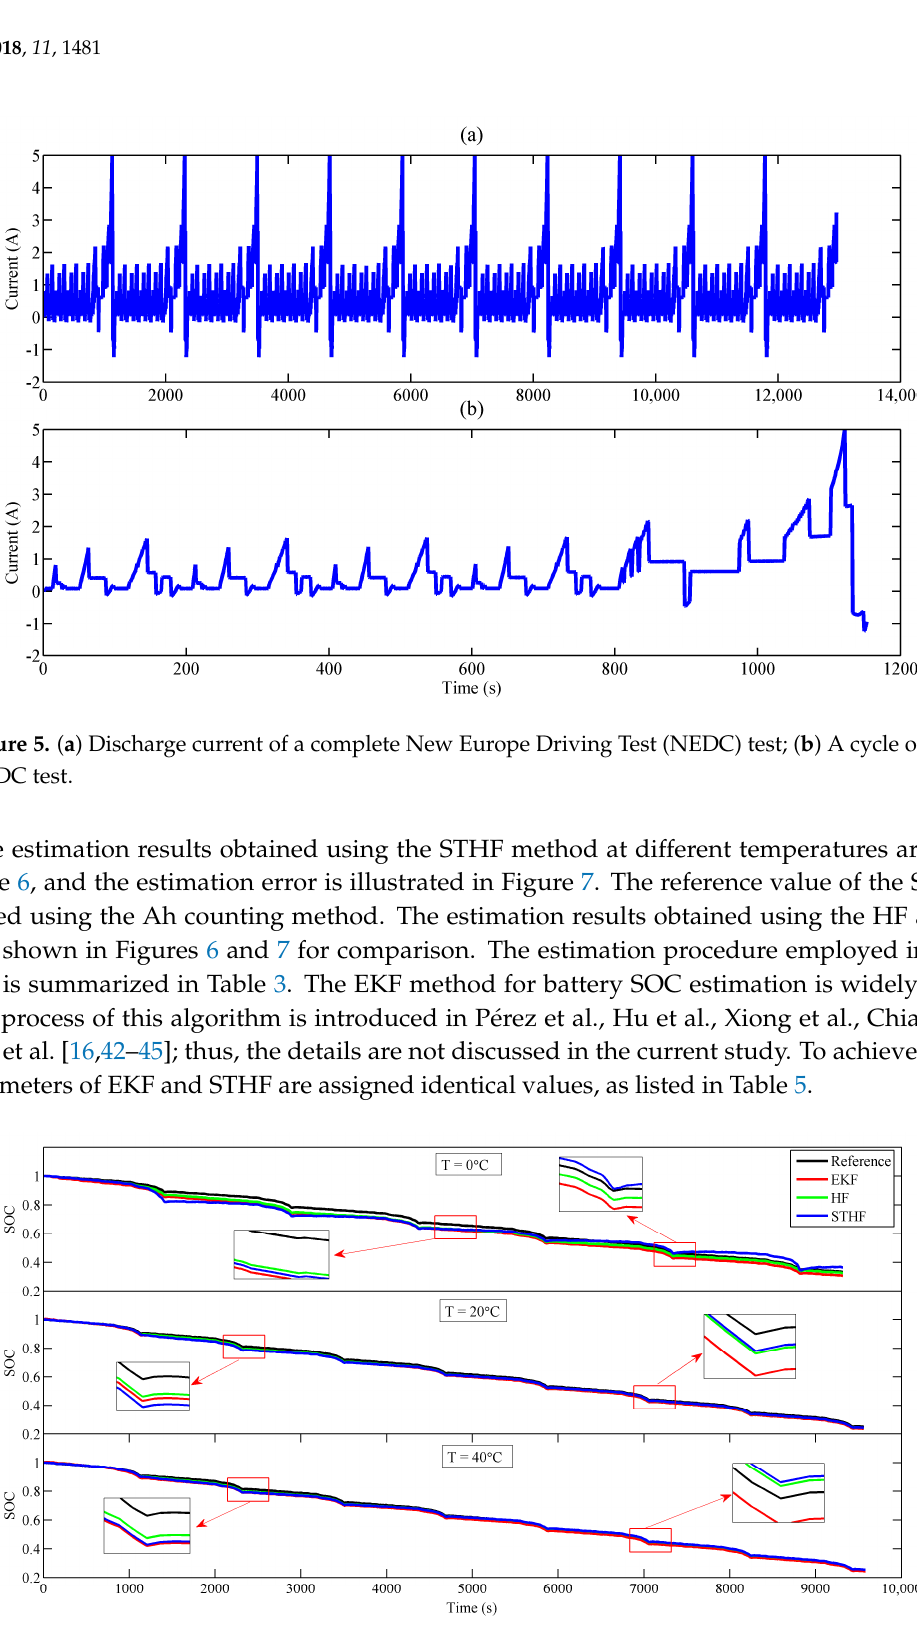
Figure 6. Estimation results of strong tracking H-infinity filter (STHF), H-infinity filter (HF), and extended Kalman filter (EKF) with white Gaussian